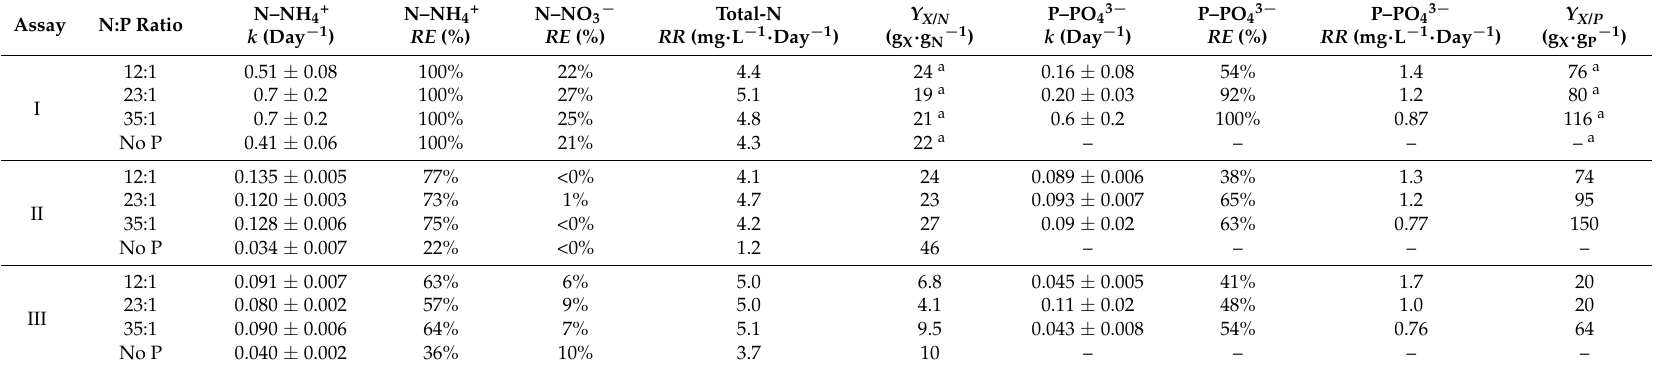
Table 2. NH 4+ , NO 3 − and PO 43 − removal parameters determined for assays I, II and III under different N:P